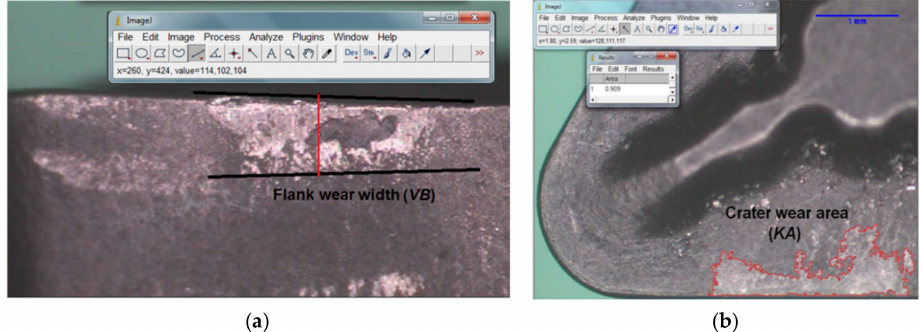
Figure 4. ( a ) Tool flank wear and ( b ) crater wear (stereoscopic optical microscopy (SOM) images 30 ×